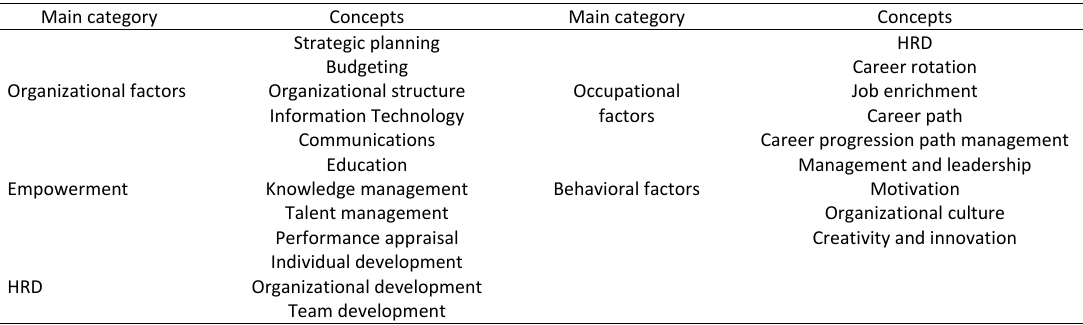
Table 3. The categories extracted from the research